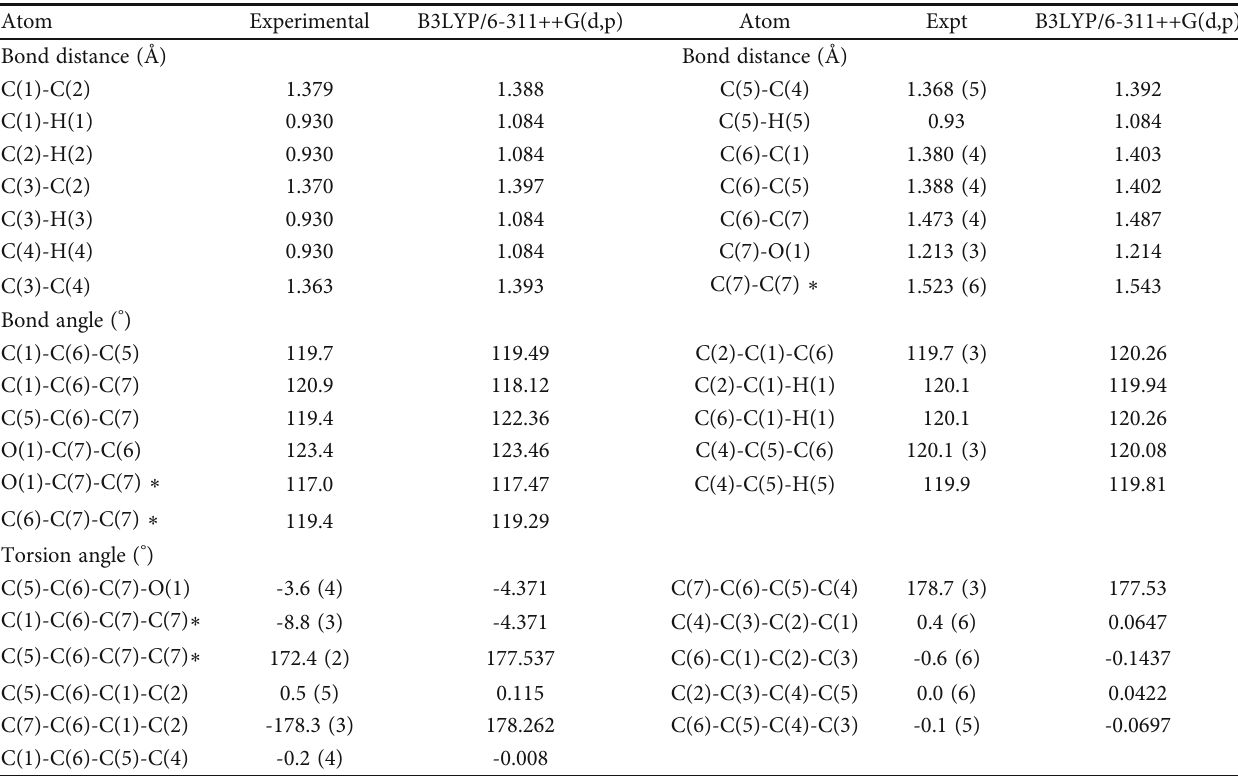
Figure 1: Optimized structure of benzil. Table 1: Geometric parameters of